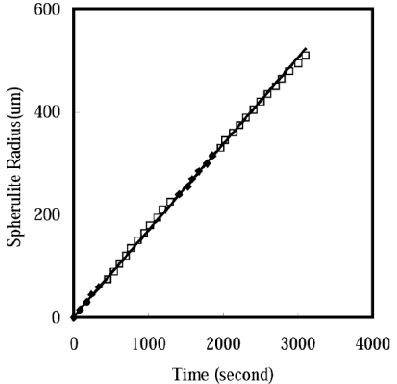
Figure 9. Growth profile of a PLLA banded spherulite crystallized at 135 ◦ C showing the almost same radial growth rate of the bright and dark bands. The open data points indicate the bright bands and the closed points indicate the dark bands. Reprinted with permission from Ref. [42]. Copyright (2005) Elsevier, Ltd.